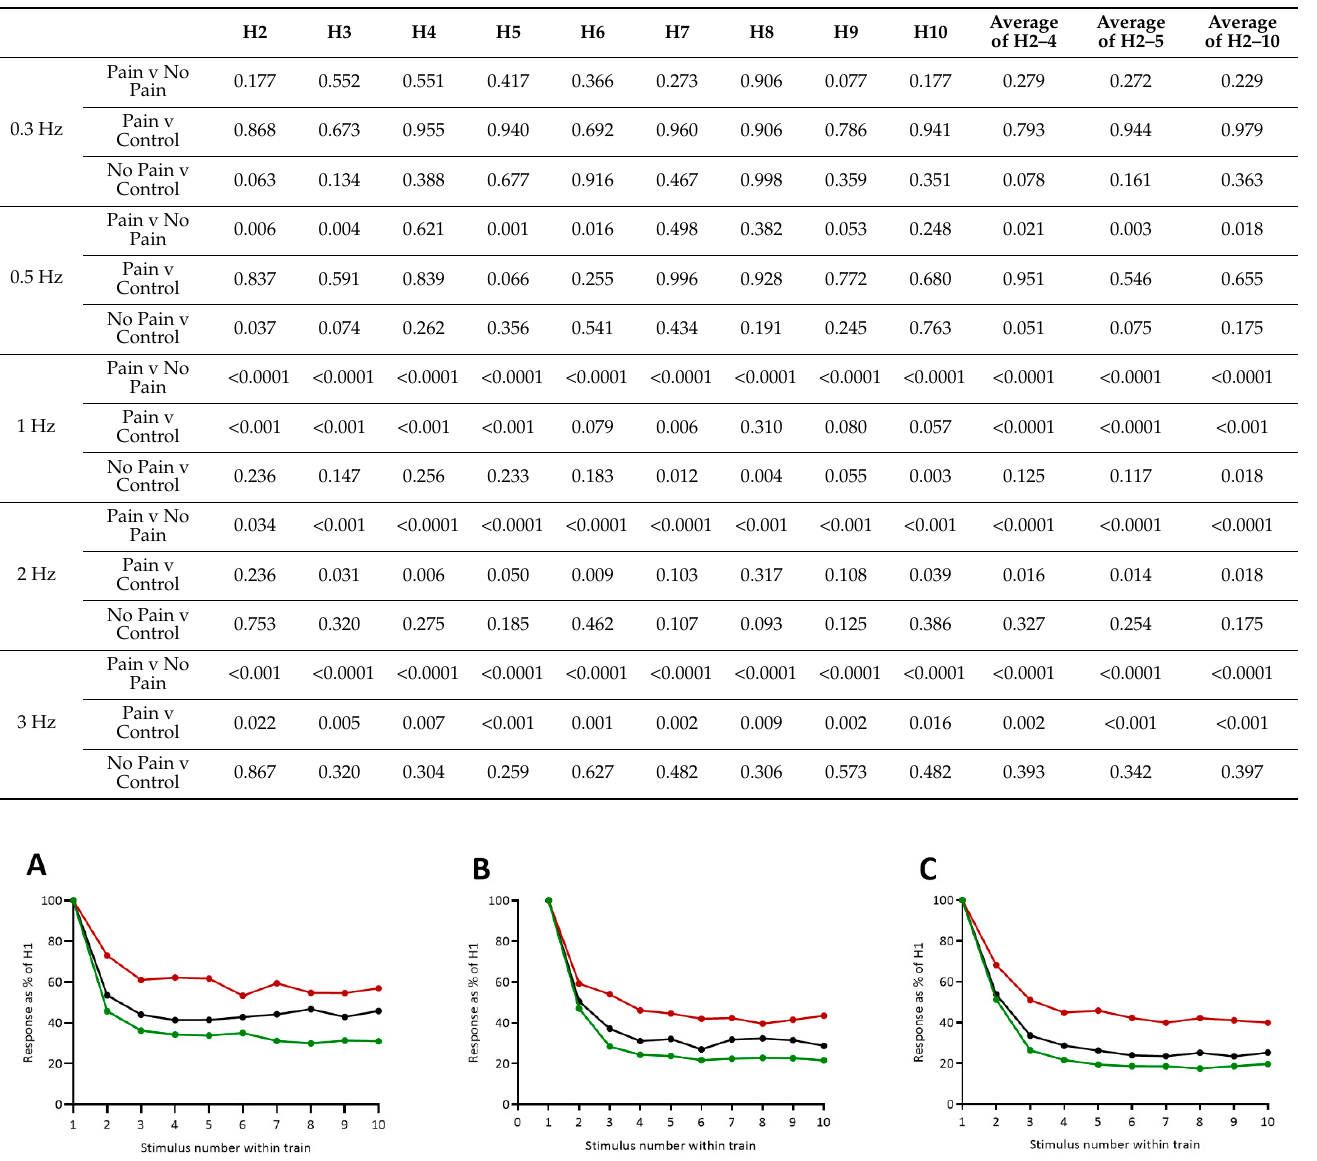
without pain, and control subjects at 0.3, 0.5, 1, 2 and 3 Hz. Between group means compared using one-way ANOVA and